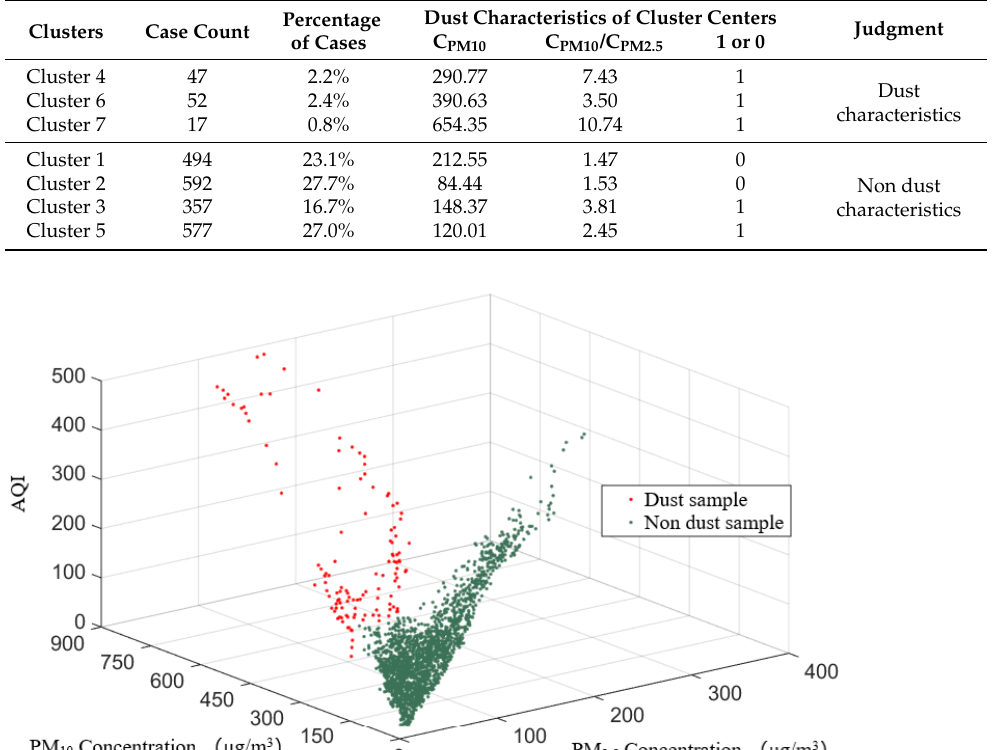
Table 4. Comparison between the recognition results of 4 algorithms and criterion method.